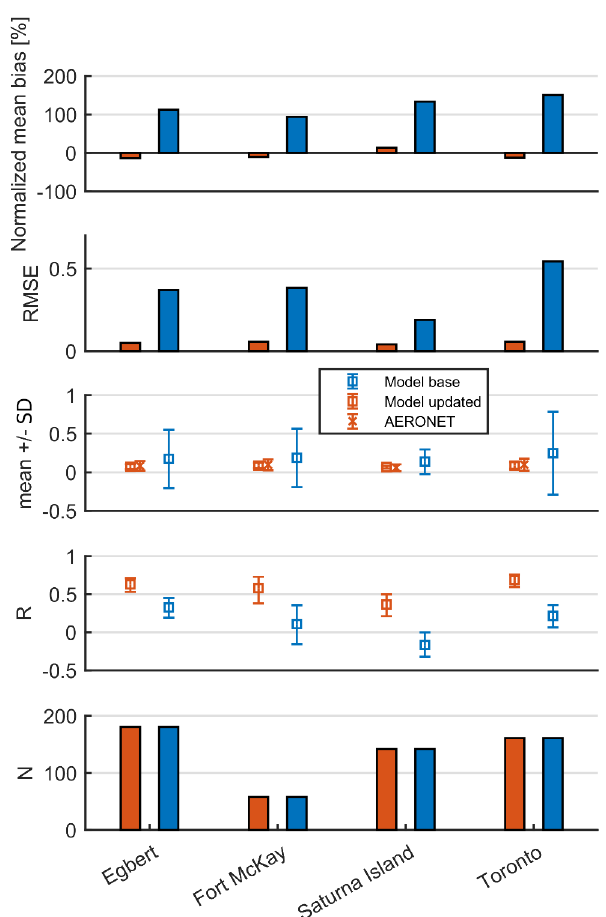
Figure 5. Statistical scores of GEM-MACH AOD with the previous (base) and the improved version of MESSy-JVAL vs. AERONET AOD at 580nm in June 2018 at four Canadian AERONET sites: Eg- bert (44.23 ◦ N, − 79 . 78 ◦ W), Fort McKay (57.18 ◦ N, − 111 . 64 ◦ W), Saturna Island (48.78 ◦ N, − 123 . 13 ◦ W) and Toronto (43.79 ◦ N, − 79 . 47 ◦